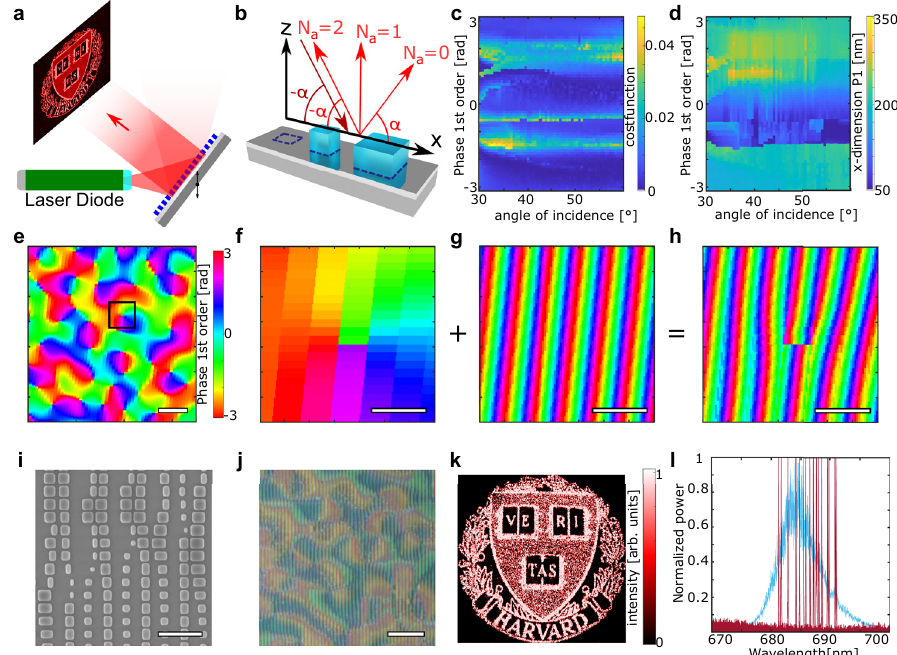
Fig. 4 Metasurface external cavity laser (MECL) with holographic output beam. a Schematic of the MECL, showing the target holographic image. b Schematic of a supercell containing three pillar locations, one of them empty. The size of the supercell is chosen in such a way that the angle of the second local diffraction order matches the incident angle of the incoming light. c Cost function of the supercell library elements, see main text for de fi nition. d Example of supercell-library parameter: x -dimension of the center pillar in each supercell of the library. e Detail of the designed holographic phase pro fi le C n, m ) imposed onto the fi rst order, scale bar 10 µ m. f Zoom in of the region marked by black rectangle in e , scale bar 2 µ m. g For the same region in f , 1,0 ( the pro fi le of G 1,0 ( x, y ) is shown; scale bar 2 µ m. h For the same region in F and G, the resulting phase pro fi le in the fi rst order T 1,0 ( n, m ), is shown; scale bar 2 µ m. i SEM image of the metasurface, scale bar 2 µ m. j Optical microscope image of the metasurface, scale bar 20 µ m. k Hologram projected on and measured by a CCD camera. The Harvard logo occupies 16° of arc. l Wavelength tuning (red) and electroluminescence spectrum (blue) for I = 65 mA, having a central wavelength of 685